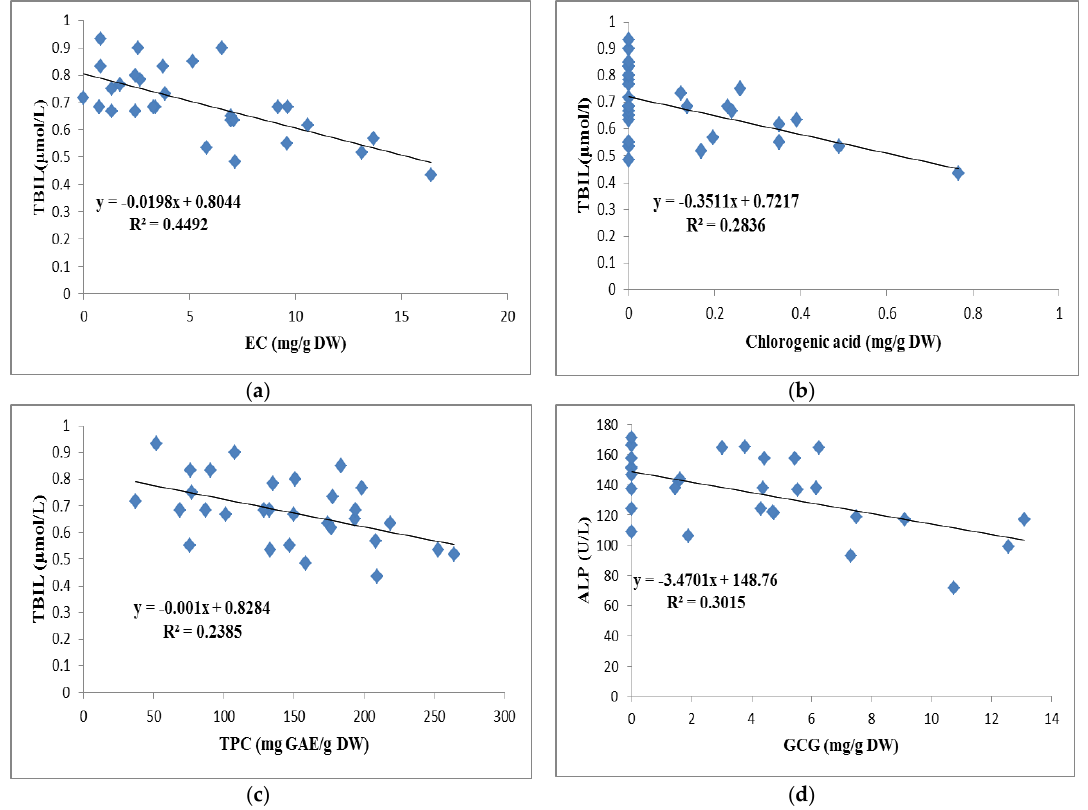
Figure 8. Correlations between EC and TBIL ( a ), chlorogenic acid and TBIL ( b ), TPC and TBIL ( c ), GCG and ALP ( d ). EC, epicatechin; TBIL, total bilirubin level; TPC, total phenolic content; GCG, gallocatechin gallate; ALP, alkaline phosphatase.